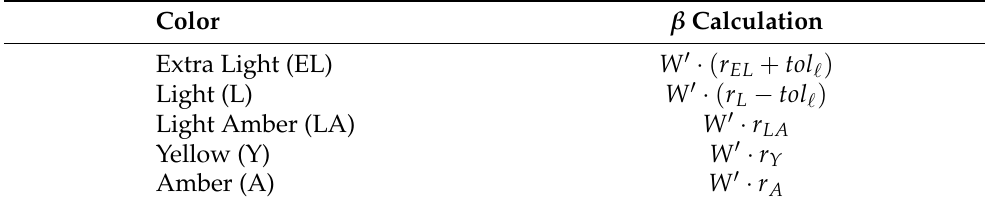
Table 4. Types of